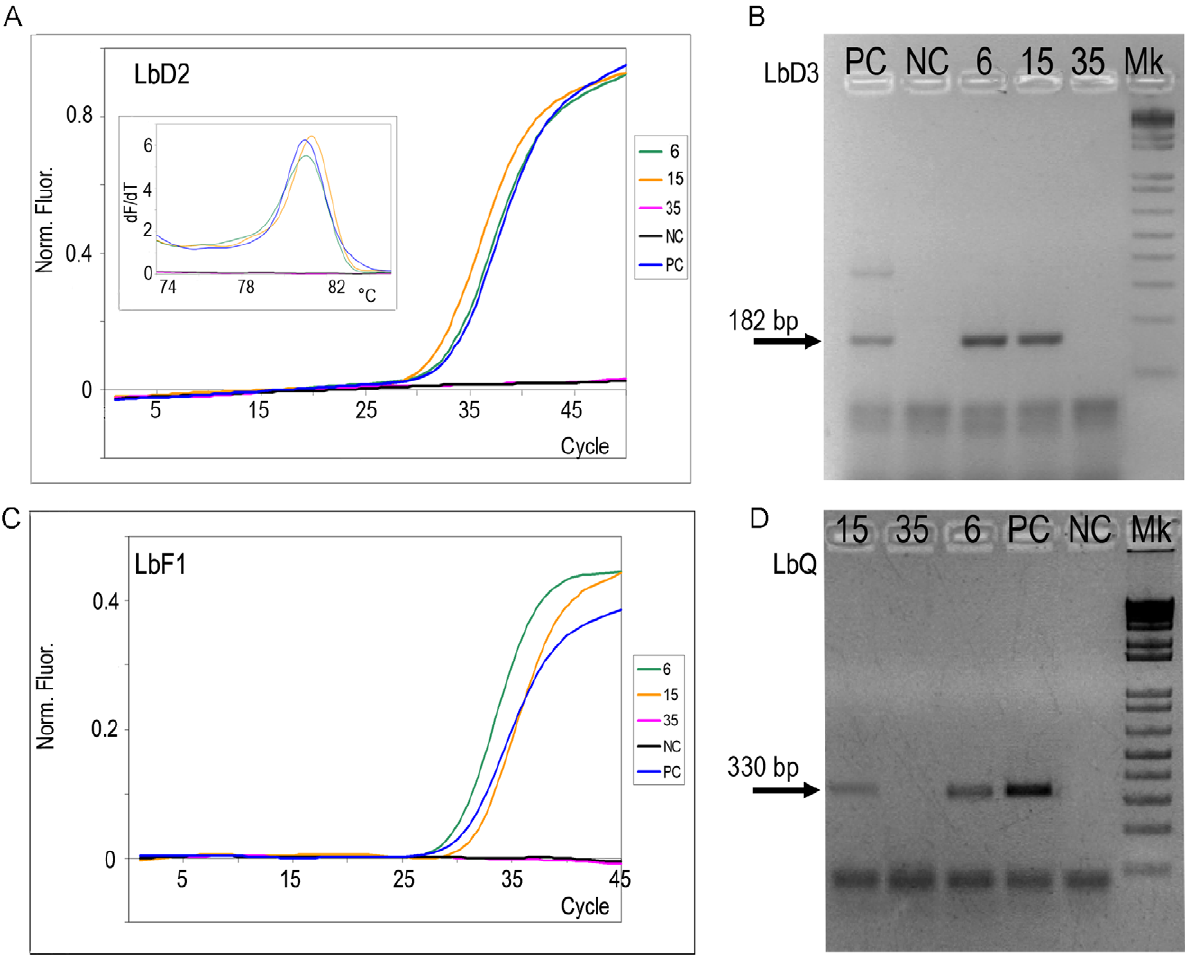
Figure 2. Examples of the outputs of the four best performing PCR methods. A. LbD2 ; B.LbD3, C. LbF1 and D. LbQ. The methods are described in Materials and Methods and Table 1. 6, 15: seropositive samples; 35; seronegative sample (Table 3). PC: Positive control: 10 fg/ m l of T.cruzi VI. NC. Negative Control: Master Mixes devoid of DNA.